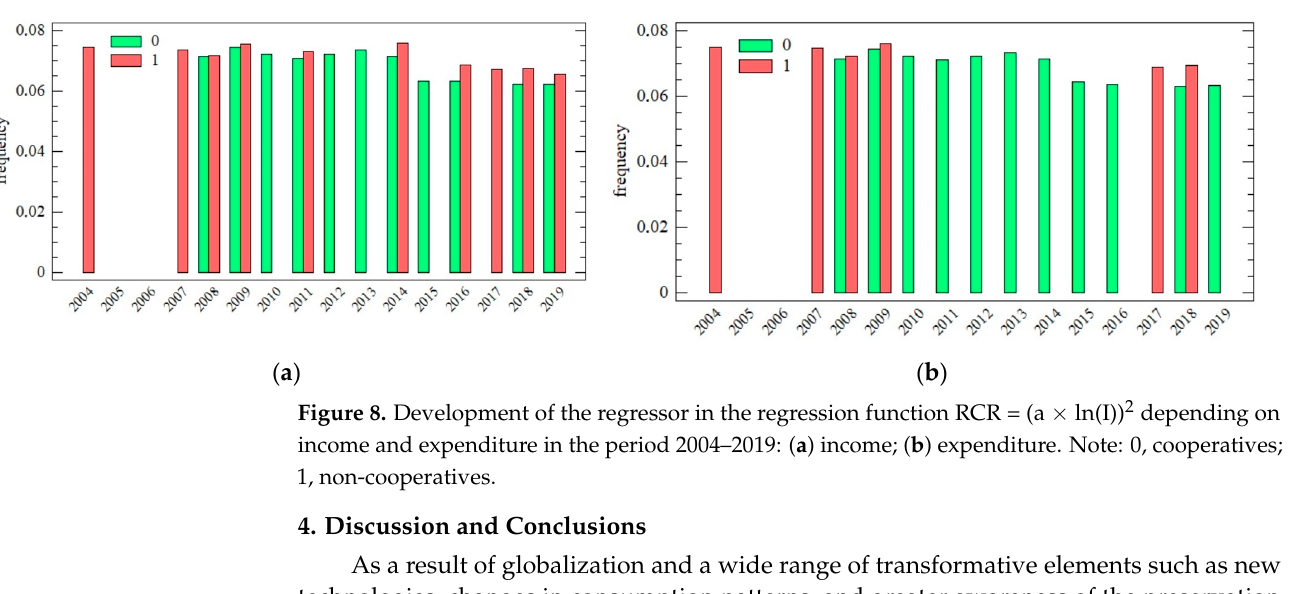
Figure 8. Development of the regressor in the regression function RCR = (a × ln(I)) 2 depending on income and expenditure in the period 2004–2019: ( a ) income; ( b ) expenditure. Note: 0, cooperatives; 1, non-cooperatives.